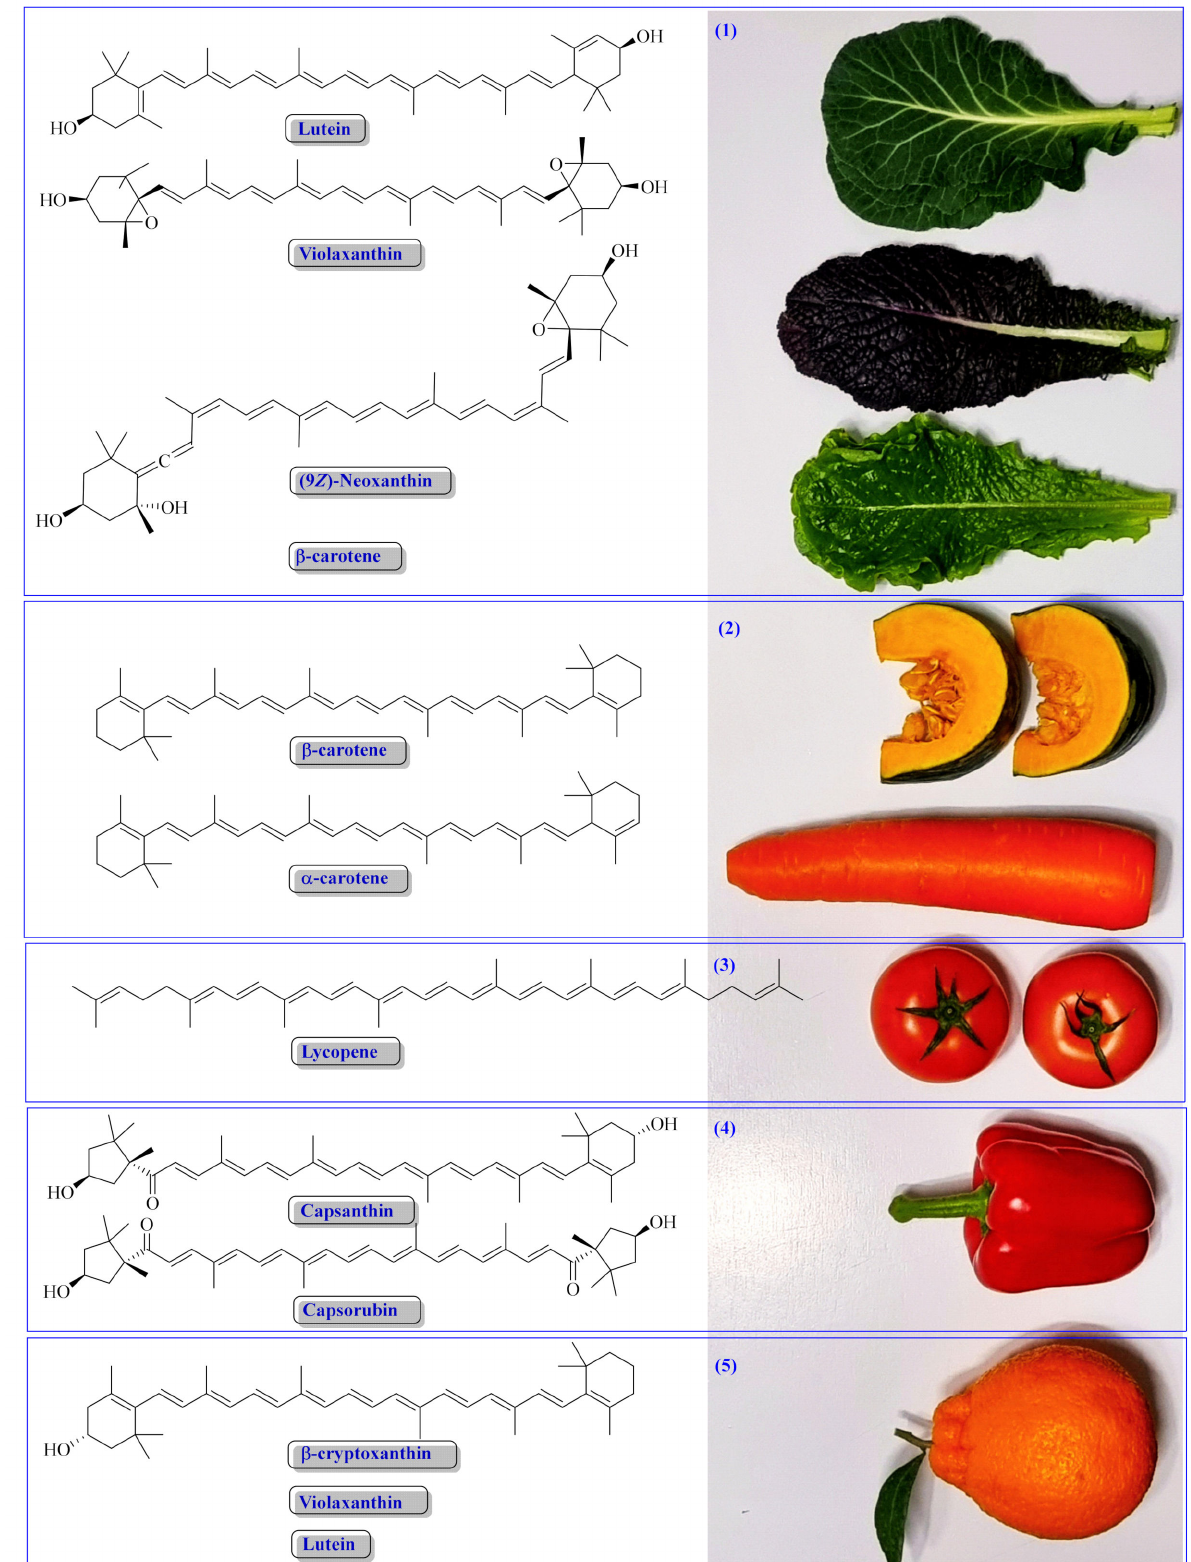
Figure 4. The dietary carotenoids obtained from the major fruits and vegetables. From top to bottom, ( 1 ) green leafy vegetables, ( 2 ) pumpkin and carrot, ( 3 ) tomatoes, ( 4 ) red paprika, and ( 5 )